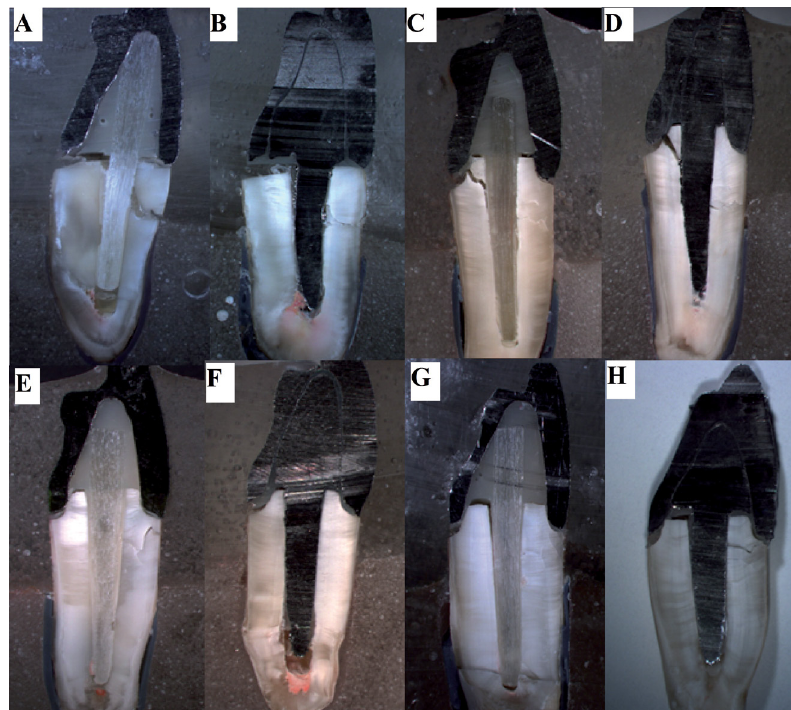
Figure 5- Representative fractures evaluated under stereomicroscope 7.5x. Roots A and B restored with fiber post and cast post and core, respectively without remaining coronal structure with displacement of the crown/core/post assembly and buccal fracture. Roots C and D restored with fiber post and cast post and core, respectively with remaining coronal structure lower than 1 mm with displacement of the crown/core/post assembly, cracks on the lingual surface of the coronal remaining and partial buccal fracture. Root E restored with fiber post with displacement of the crown/core/post assembly and total buccal fracture. Root F shows restoration with post and core with displacement of the crown/core/post assembly, both E and F roots do not have cracks on the lingual surface of the dental remaining. G and